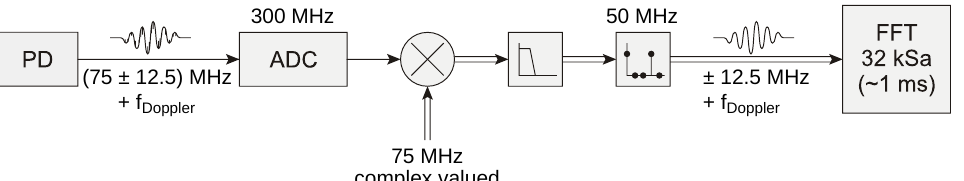
Figure 6. The electrical signals from each balanced photodetector are digitised using one dedicated ADC sampling at 300 MHz. The signal is then mixed with a complex valued 75 MHz reference signal, low-pass filtered and subsampled at a rate of 50 MHz. Finally, the signal is transformed into the spectral domain using an FFT with a block length of 32,768